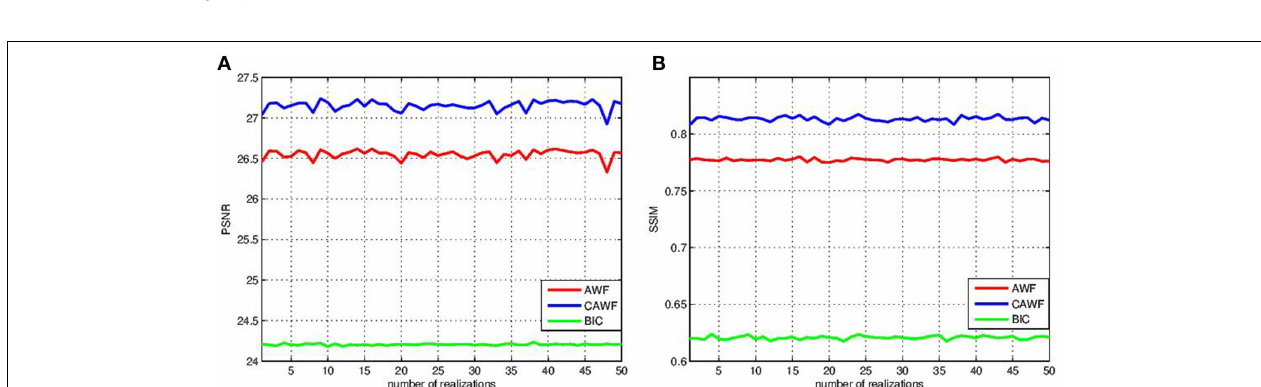
FIGURE 8 | PSNR and SSIM statistics for the various SR algorithms over 50 shift and Gaussian noise patterns realizations (A) PSNR and (B) SSIM. These results are obtained for Lighthouse image when L